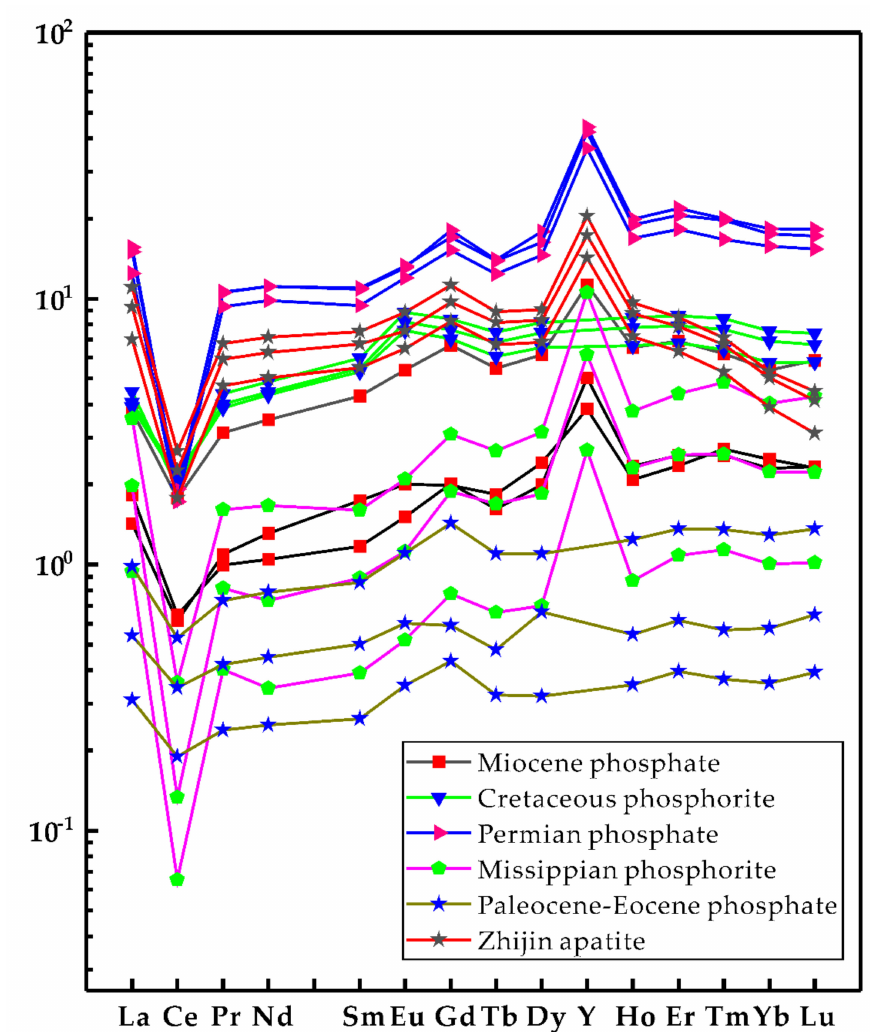
Figure 8. PAAS-normalized REY patterns of the intraclastic apatites of di ff erent ages’ phosphate or whole rock: Zhijin apatite (study area), Upper Cretaceous phosphorite (Egypt), Upper Permian phosphate (Montana, US.), Miocene phosphate (Florida, US.), Middle Mississippian phosphorite (Alaska, US.), Paleocene-Eocene phosphate (Tunisia)